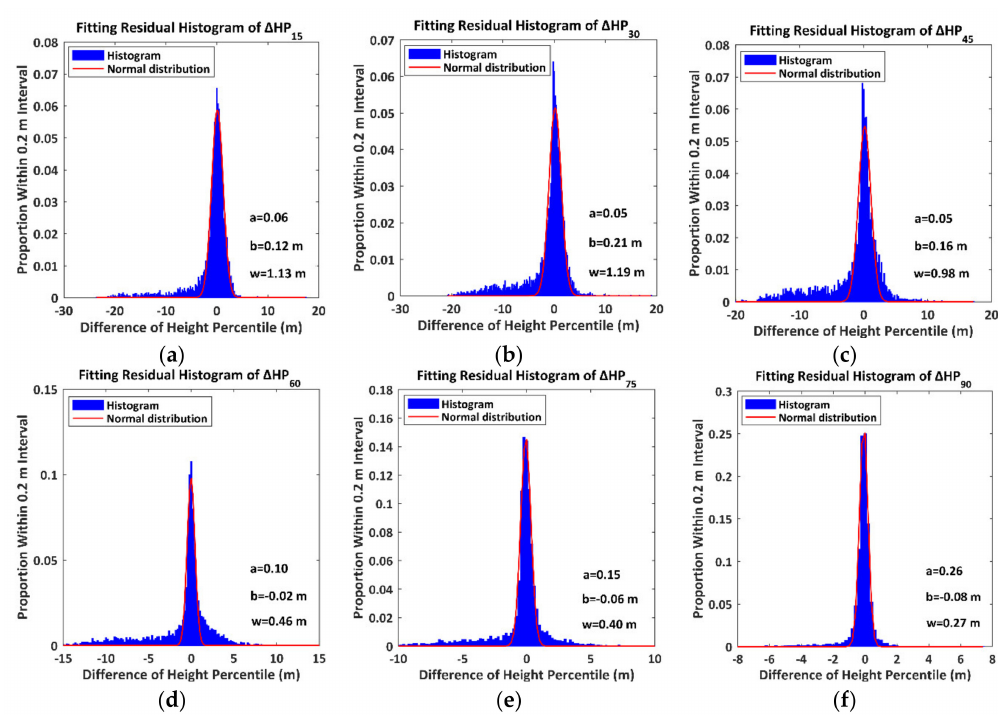
Figure 12. The histograms of the residuals of the differences of the height percentile. The symbols a, b and w denote the amplitude, centroid and sigma width of the fitting normal distribution. ( a ) ∆ HP 15 ; ( b ) ∆ HP 30 ; ( c ) ∆ HP 45 ; ( d ) ∆ HP 60 ; ( e ) ∆ HP ∆ HP 75 ; ( f ) 90 .